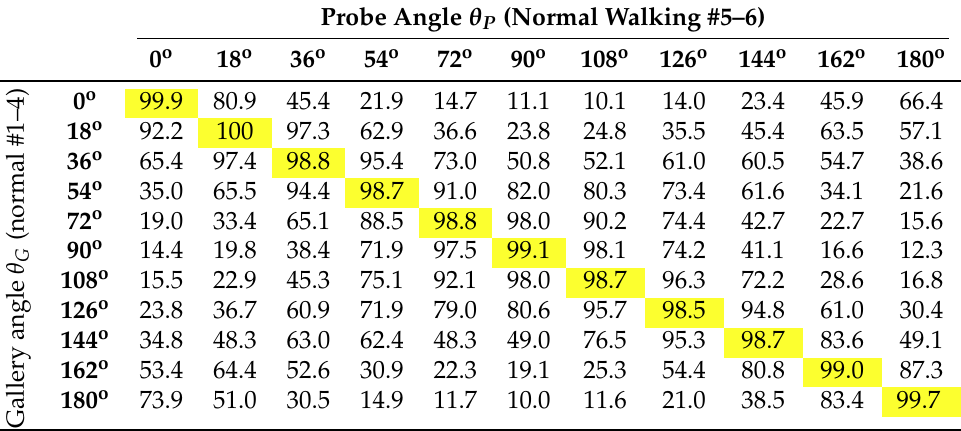
Table 5. Evaluation results using rule 2 (74 classes for the training group, 50 classes for the testing group, which is divided into gallery subset 1–4 and probe subset 5,